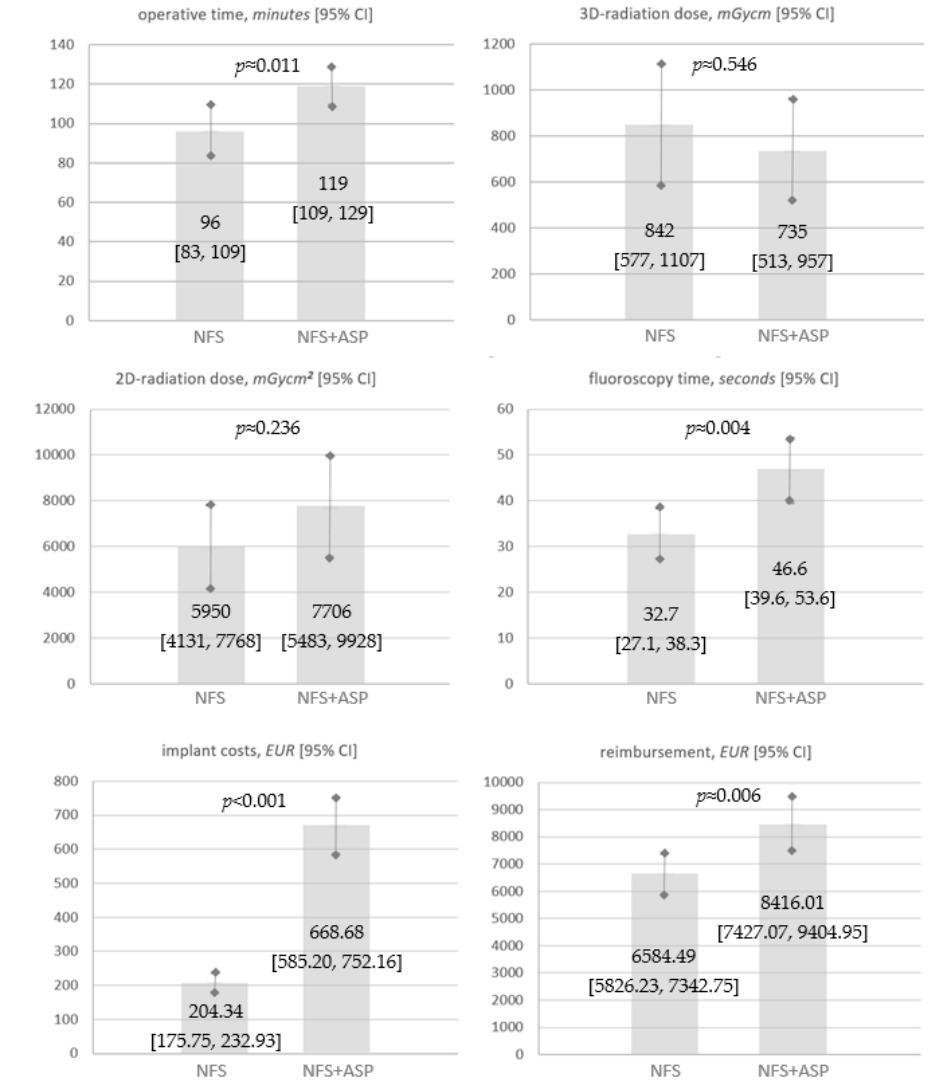
Figure 3. Study endpoints showing no statistically significant differences for 3D- and 2D-radiation dose between groups. Statistically significant differences were found for operative time ( p ≈ 0.011), fluoroscopy time ( p ≈ 0.004), procedural costs ( p < 0.001), and reimbursement ( p ≈ 0.006). Statistical significance was assumed at a p < 0.05 (Student’s t -test). NSF indicates navigation-assisted screw fixation; ASP, additional sacroplasty; 2D, two-dimensional; 3D, three-dimensional; 95% CI, 95% confidence interval; mGycm, milligray centimeter. Although expenditure for iliosacral/trans-sacral screw osteosynthesis was similar in both groups ( p ≈ 0.174), significantly higher average implant costs ( p < 0.001) and reim- bursements ( p ≈ 0.006) were found in NSF + ASP. Average reimbursement differences be-